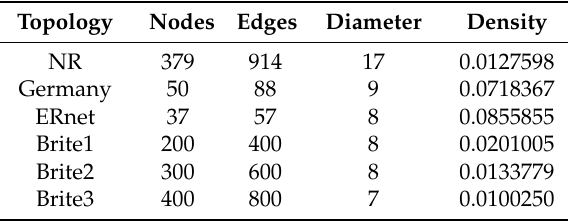
Table 1. Topology characteristics: The topologies examined had different node and edge counts, and diameters and densities. Topology Nodes Edges Diameter